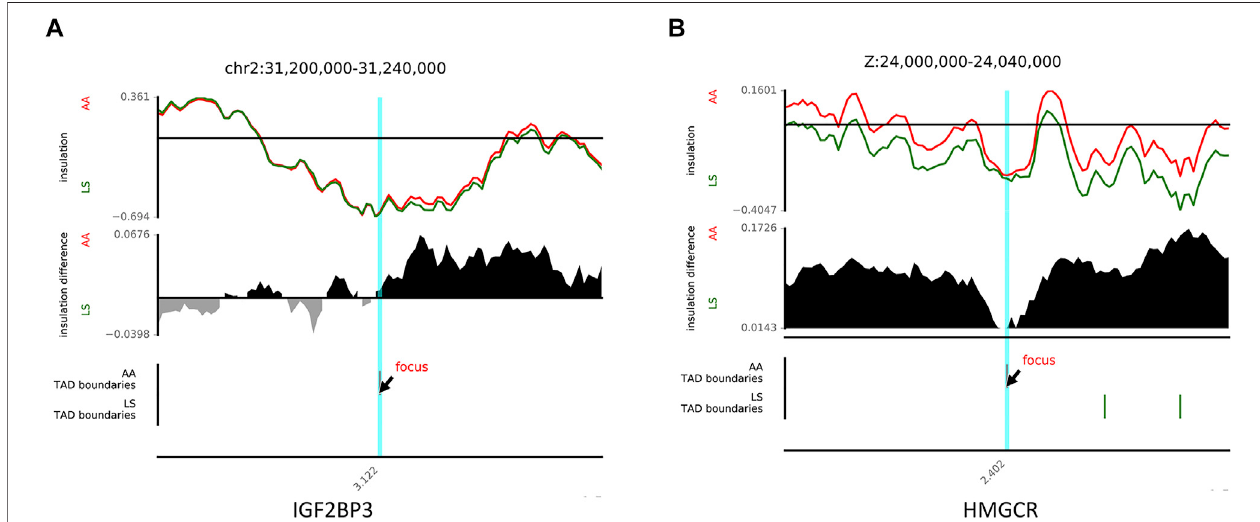
FIGURE6| Theexamplesofdisappearingandreforming ofTAD. (A) TADdisappearingshowinganexampleofTADboundarybetweenAA(red)andLS(green)on chr2(chr2:31,200,000-31,240,000). (B) TADreformingshowinganexampleofTADboundarybetweenAA(red)andLS(green)onchrZ(chrZ:24,000,000-24,040,000).